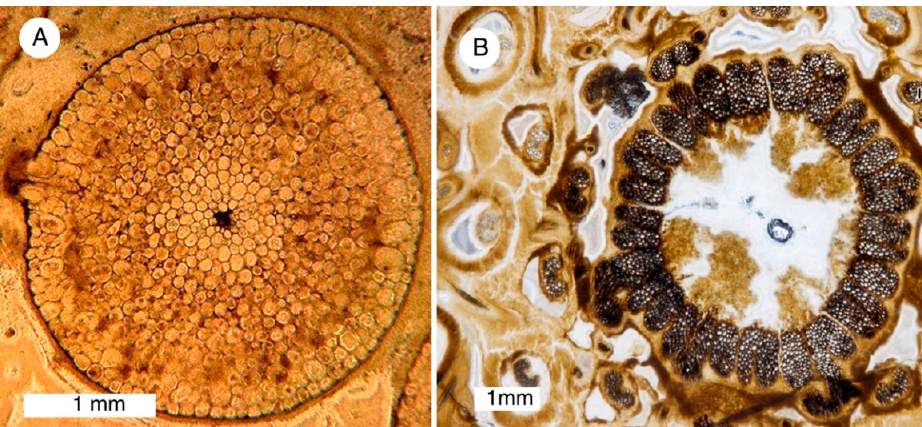
Figure 9. Siliceous permineralization as revealed in acetate peels. A. Rhynia Gwynne-vaughanii , transverse view of stem, Devonian, Rhynie chert, Scotland [19,20]. Photo courtesy of Paleobotany Research Center University of Münster; B. Millerocaulis zammerae , transverse view of stem, Jurassic, Patagonia, Argentina [21]. Photo courtesy of Ana Sagasti).